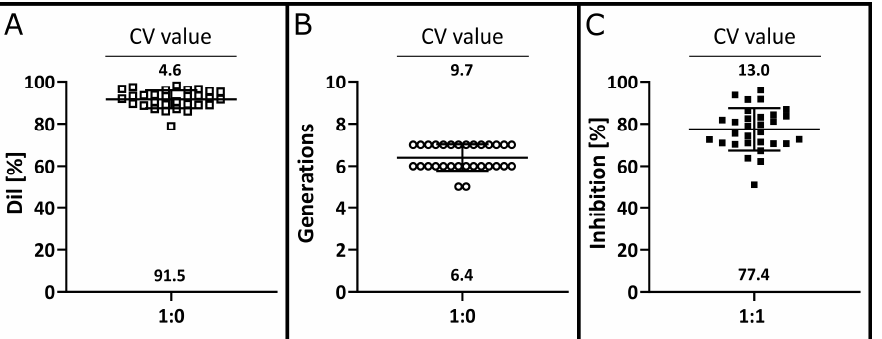
Figure 7. Robustness in the proliferative response of different PBMC donor pairs. After four days of T cell stimulation, the proliferative capacity using the Dil value ( A ), the number of T cell generations ( B ) and the inhibition by MSC in a 1:1 ratio ( C ) was determined for n = 30 PBMC donor pairs. The mean value of each analysis parameter is indicated at the bottom of the plot. The CV values were chosen as validation parameter and are indicated above the plots.